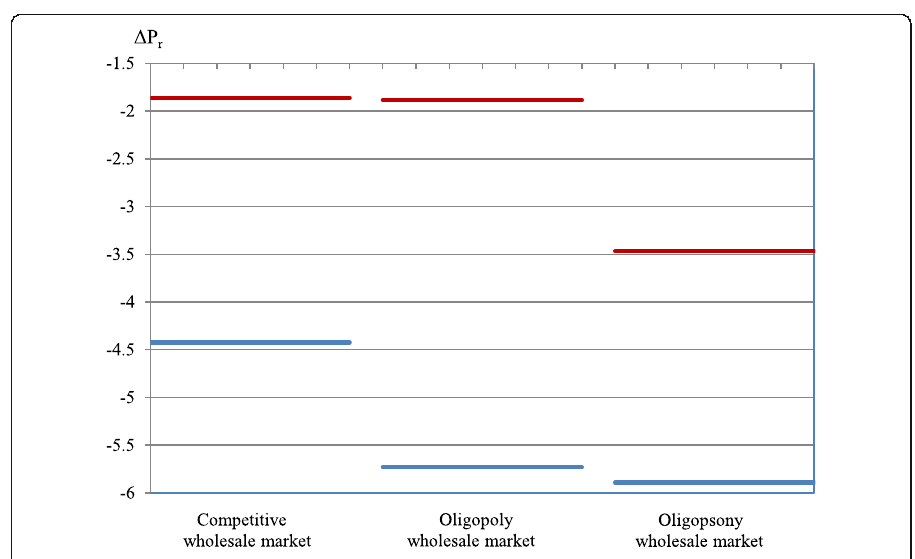
Fig. 6 Retail price decrease ( Δ P r ) in two scenarios of anti-trust methods under various wholesale market structures. Note: The red lines represent the retail price decrease ( Δ P r ) when only retailers ’ seller power is weakened (from N = 2 to N = 3). The blue lines represent the retail price decrease ( Δ P r ) when both retailers ’ seller power (from N = 2 to N = 3) and processors ’ buyer power (from M = 2 to M = 3) are weakened. The retail price decreases | Δ P r | (blue lines) are larger when the two forms of market power are jointly